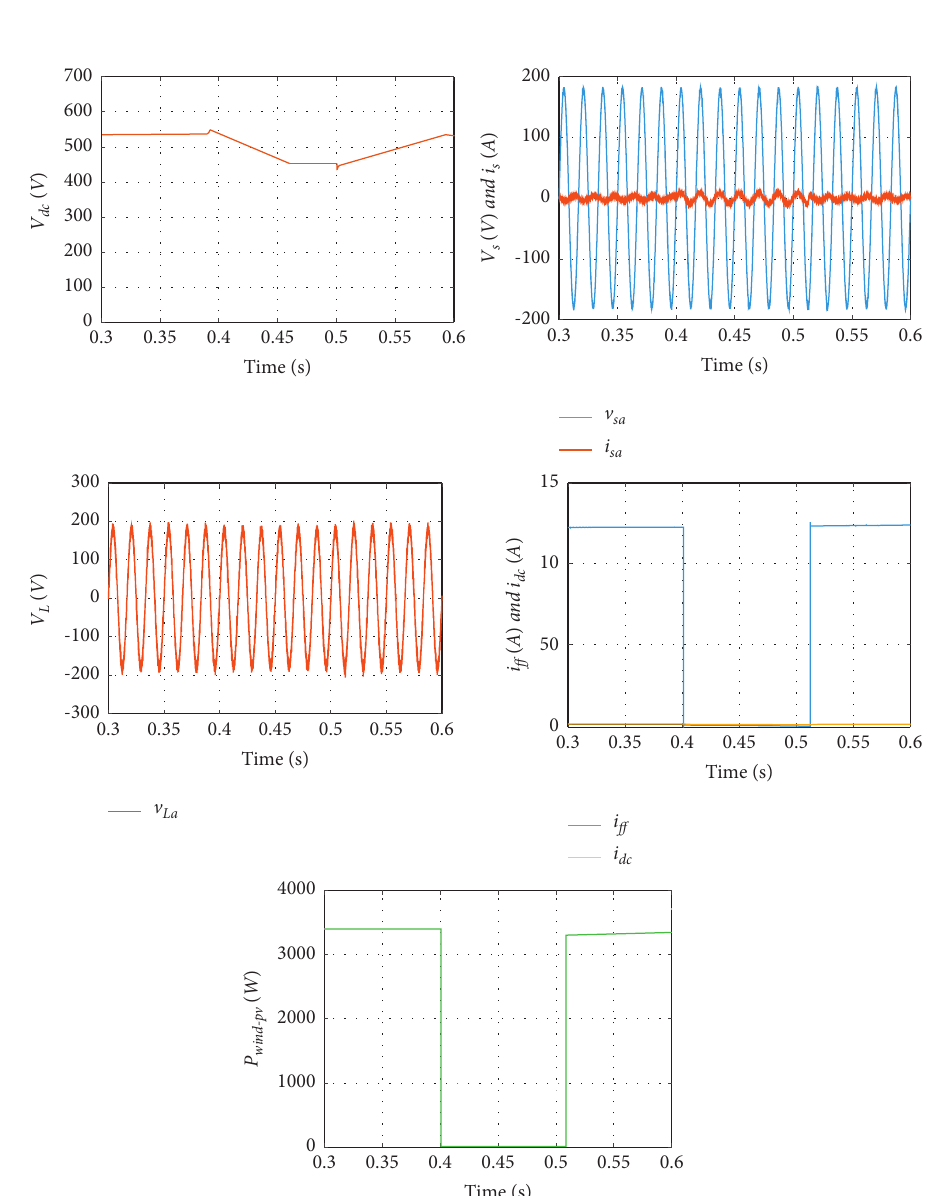
Figure 8: Active filtering along with active power interjection is performed by Wind-PV-UPQC with P Phase “ a ” grid current and grid voltage, load voltage, i ff current, i dc current, and Wind and Photovoltaic power P and solar irradiance variations using